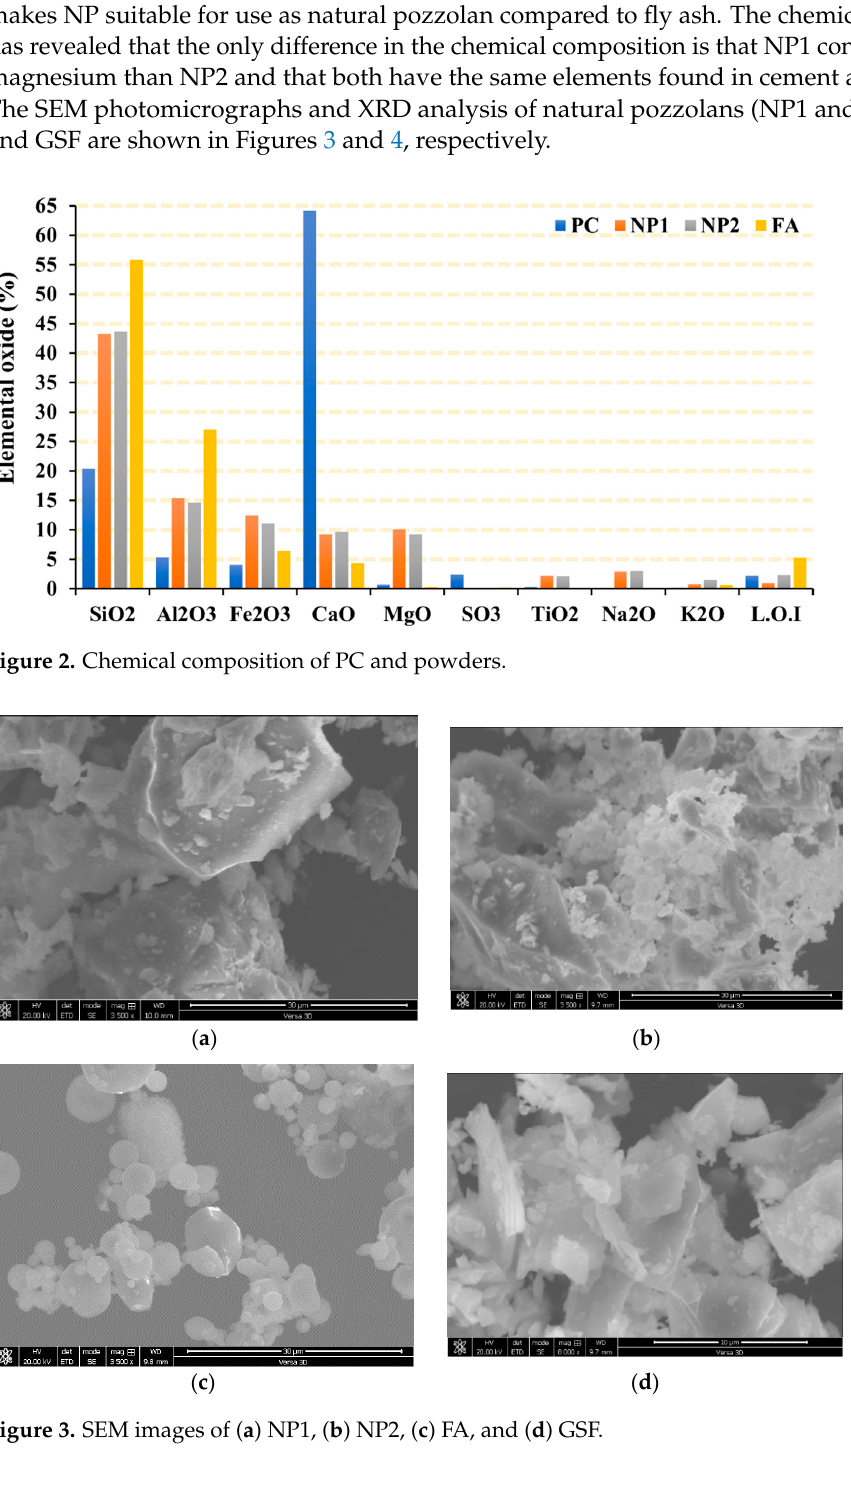
Figure 4. Volume ‐ based particle ‐ size distribution curves of PC, NP1, NP2, FA, and GSF. NP1